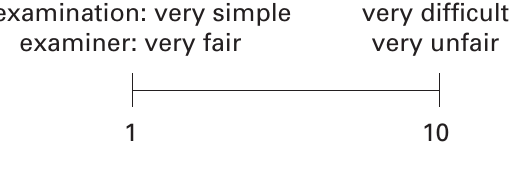
Use of visual ana- logue scale to assess severity of examina- tion and fairness of examiner.